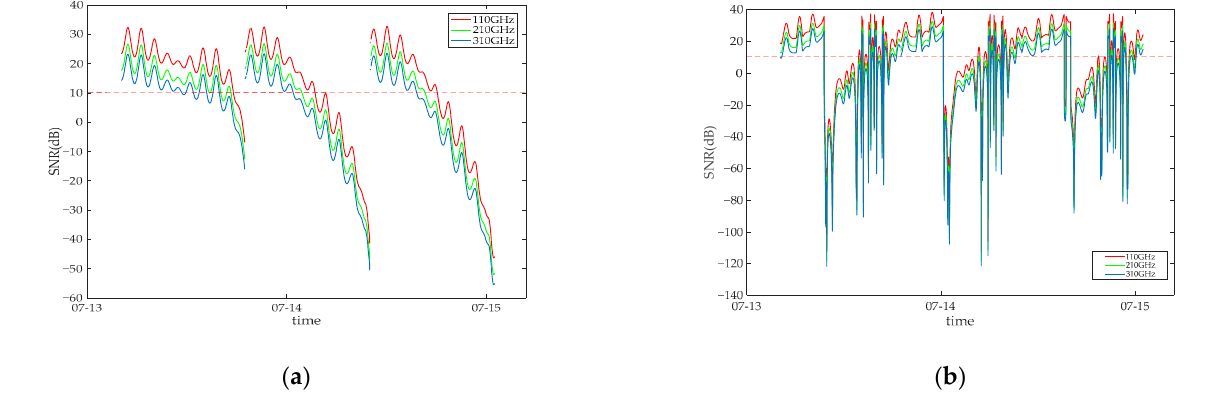
Figure 14. Variation of signal-to-noise ratio with time at different communication frequencies in inter-satellite terahertz communication system: ( a ) uplink terahertz communication link for LEO- GEO; ( b ) downlink terahertz communication link for GEO-LEO.